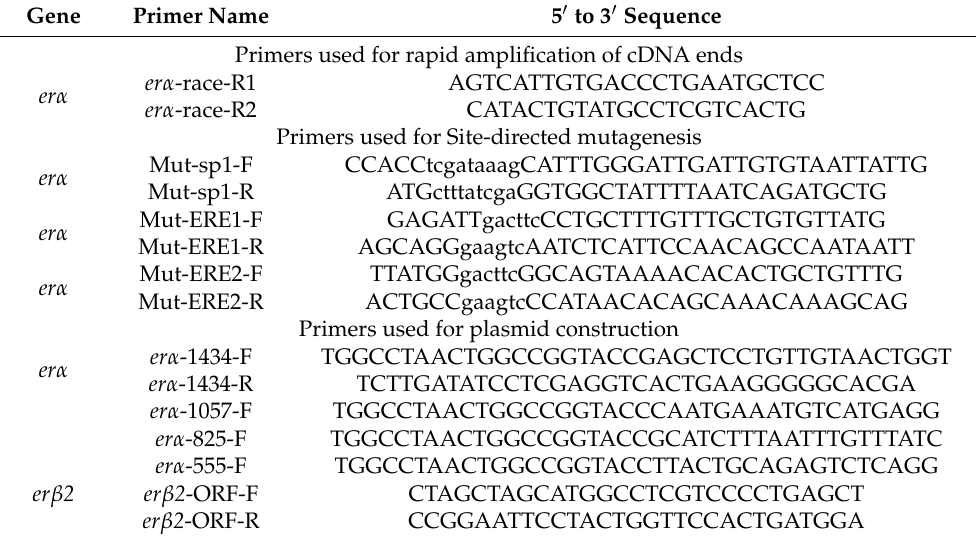
Table 3. Primers used for rapid amplification, site-directed mutagenesis, and plasmid